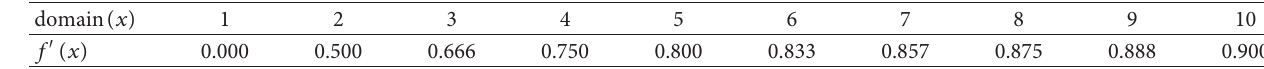
Table 3: Numerical result of the function [ f ′ ( x )